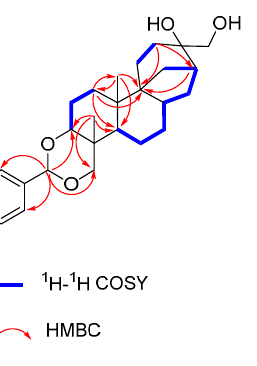
Figure 3. Thermal ellipsoid representation of 4 . Table 1. NMR Data for 1 in Acetone- d 6. Pos.